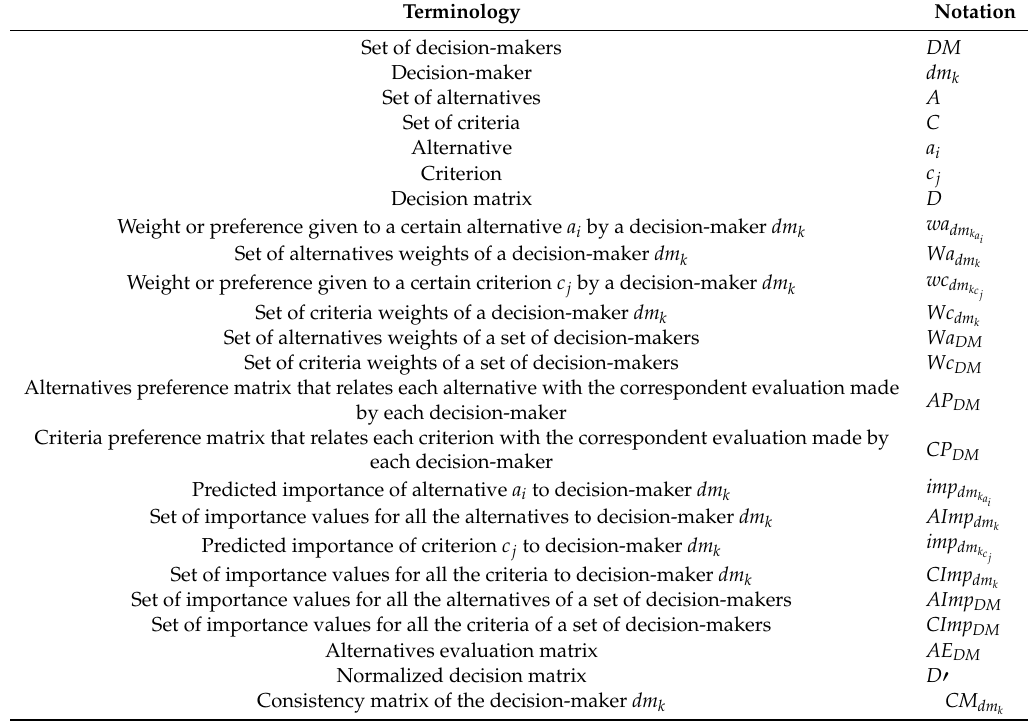
Table 1. Notation